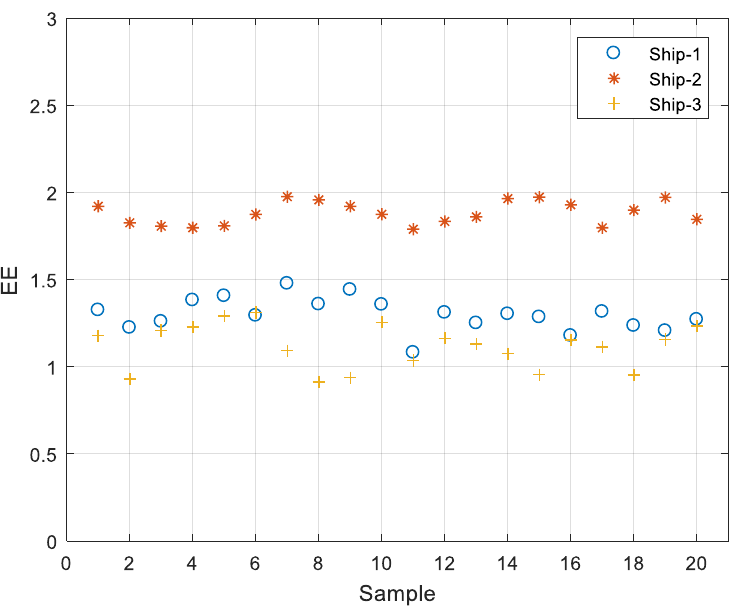
Figure 7. The EE distribution for S-RN signals.